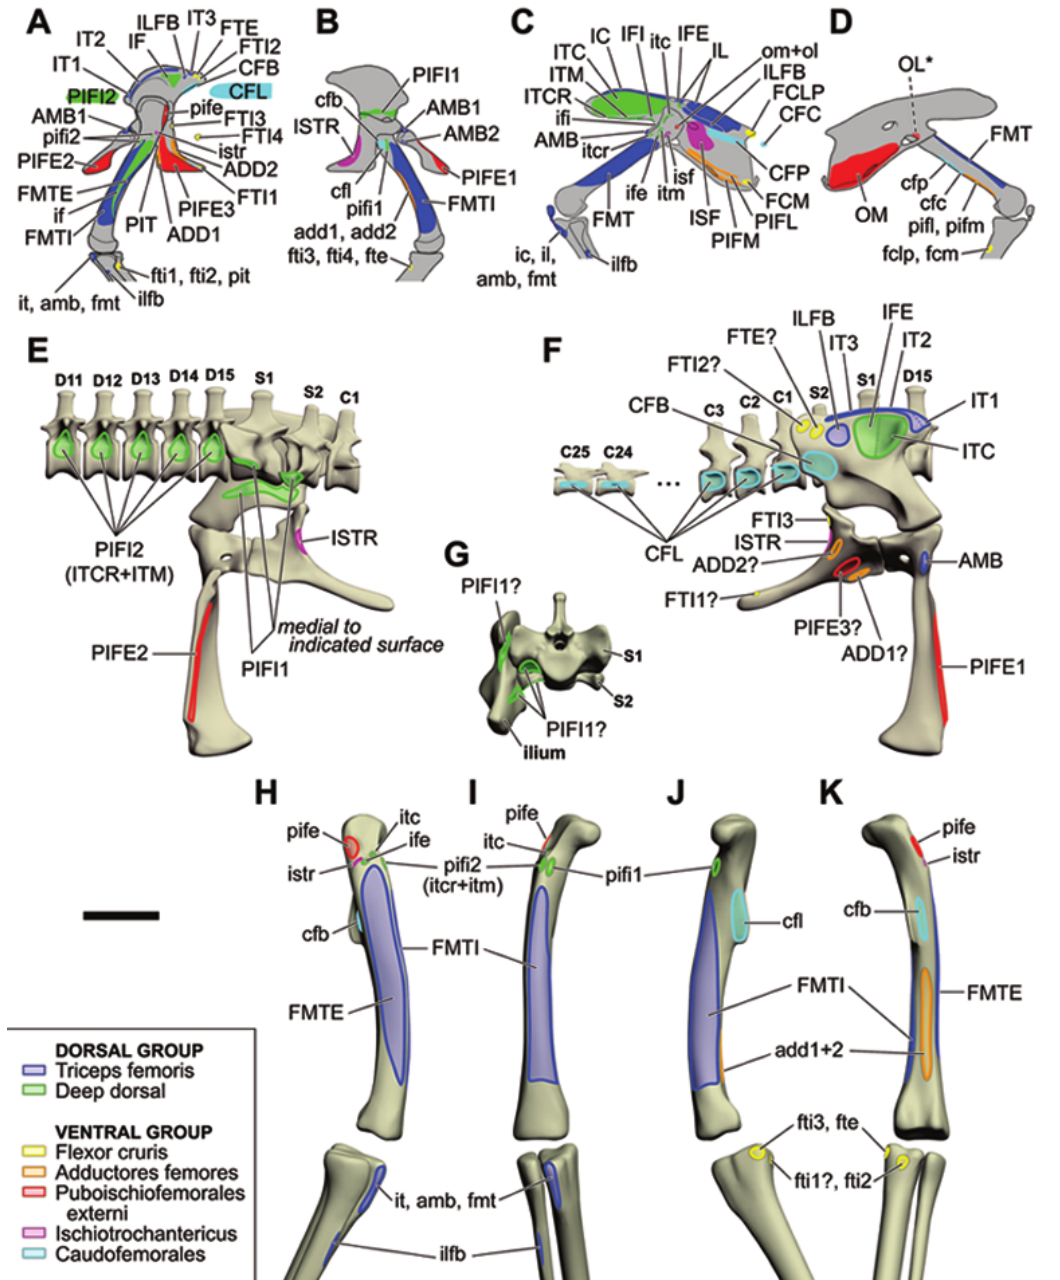
Fig. 2 – Areas of muscle origin (upper case) and insertion (lower case) in extant Crocodylia (A and B) and Aves (C and D), and proposed reconstruction for Staurikosaurus indicated over a 3D reconstruction of the pelvis and vertebrae (E-G) and hind limb (H-K). Lateral view (A, C, F, H), medial view (B, D, E, J), anterior view (G, I) and posterior view (K). In G, it is shown the two possibilities for the origin of PIFI1. Abbreviations followed by question mark indicate uncertain presence of the muscle or uncertain position on the area indicated (no clear scar was observed). The asterisk in D indicates that the origin of the muscle occurs on the opposite side of the indicated surface. Dashed lines in F indicate uncertain position of the division of the areas of origin of IFE and ITC or IT1 and IT2. Scale bars: 50 mm (A-D modified from Carrano and Hutchinson